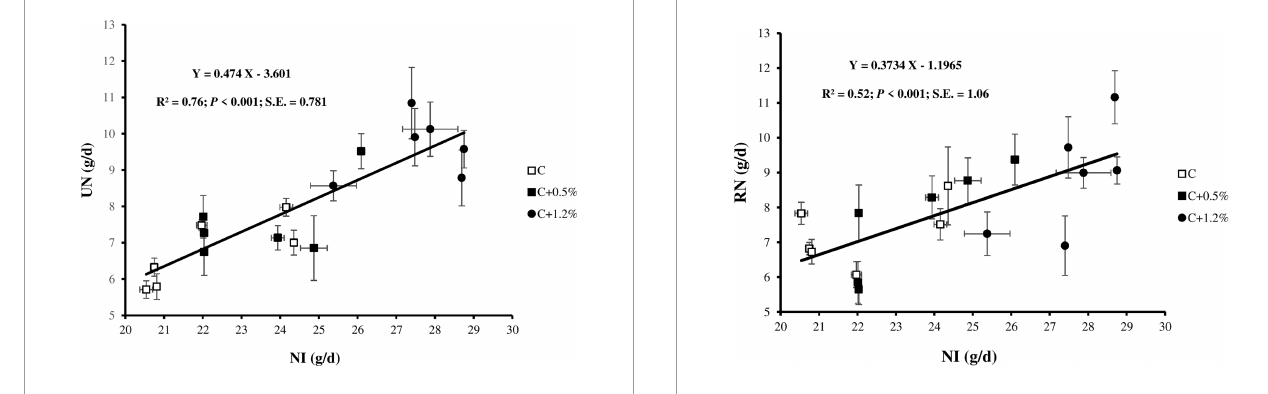
FIGURE 2 | Relationship between retained nitrogen (RN) and N intake (NI) for individual observations of the sheep offered three different levels of non- protein N: C, control dietary treatment with maintenance NI allowance; C +0.5%, control dietary treatment with maintenance plus an additional 15% NI allowance; C+1.2%, control dietary treatment with maintenance plus an additional 33% NI allowance. The error bars show SE.